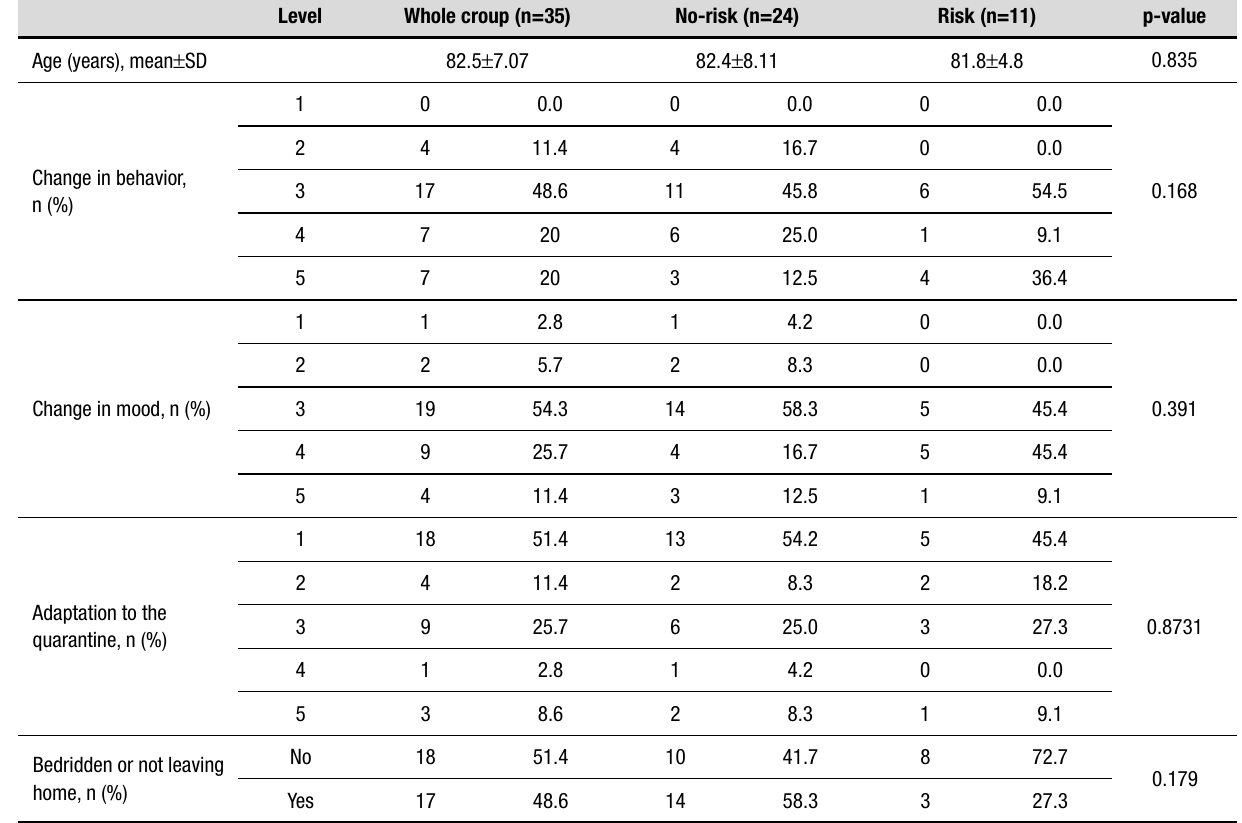
Table 2. Variables relating to the characteristics of the person with MND to the whole group and according to the risk classification defined by the SRQ-20 instrument (no-risk and risk for mental